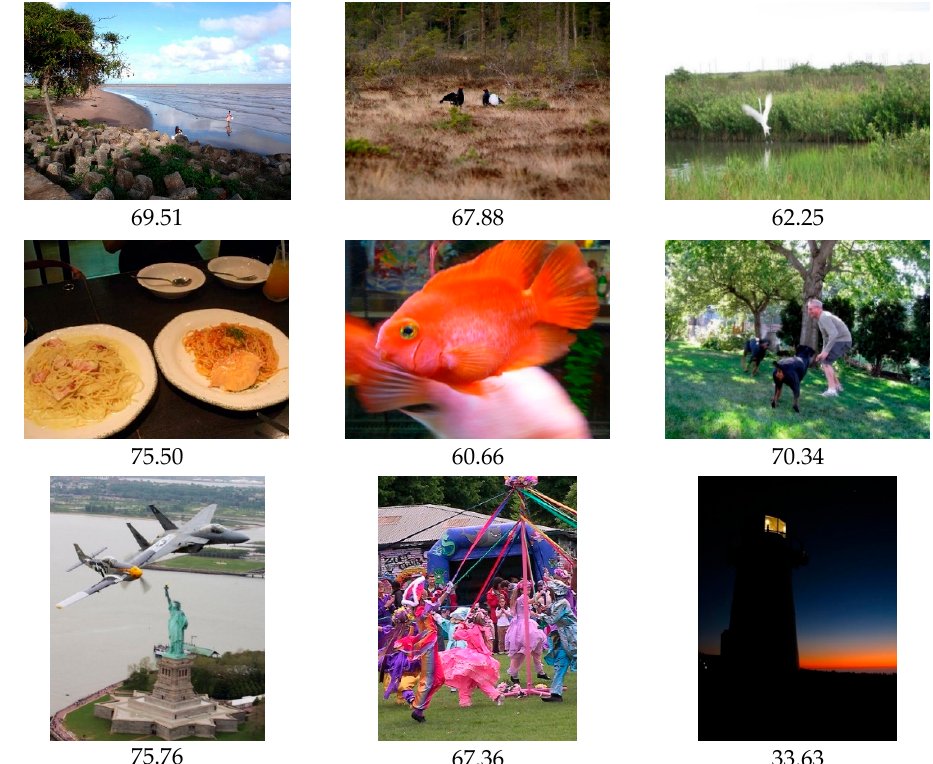
Figure 2. Examples of the ImageNet [14]. It contains natural scenes, human landscapes, animals, plants, and portraits, etc. Most of the images have various type and degree of distortion. Dynamic blurring of the subject and underexposure are relatively common. The according proxy labels are under the images. The according proxy labels are under the images, given by FRIQUEE [34].